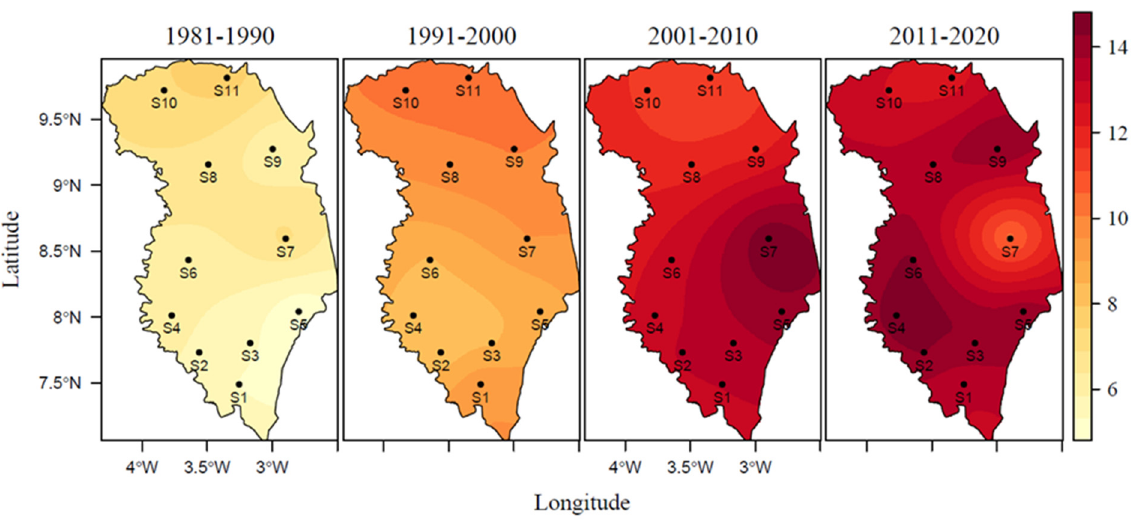
Figure 12. Spatial distribution of number of warm nights (TN90p) (%) per decade in Zanzan region. (S1 = Koun Fao, S2 = Kouassi-datékro, S3 = Tanda, S4 = Sandegué, S5 = Bondoukou, S6 = Nassian, S7 (S1 = Koun Fao, S2 = Kouassi-dat é kro, S3 = Tanda, S4 = Sandegu é , S5 = Bondoukou, S6 = Nassian, = Sapli, S8 = PN Comoé S1, S9 = Bouna, S10 = Téhini, S11 = Doropo). S7 = Sapli, S8 = PN Como é S1, S9 = Bouna, S10 = T é hini, S11 =